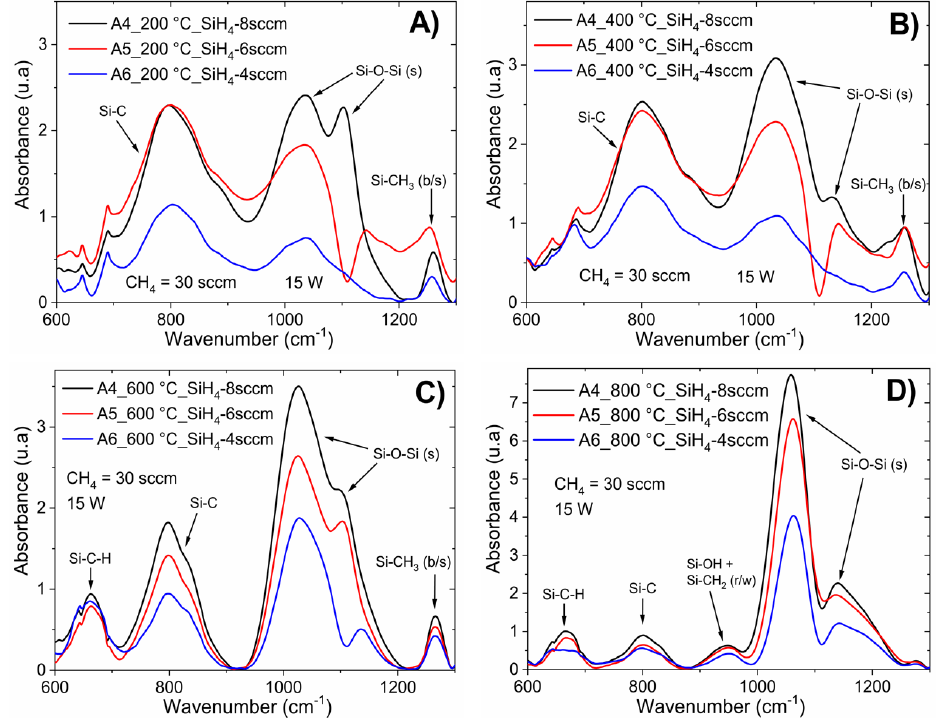
Figure 3. IR spectra for the a-Si 1 − x C x :H films deposited after fast annealing process with di ff erent R 0 ratios (from 37.5–75) and constant RF power at 15 W; upon fast annealing process at 200 ( A ), 400 ( B ), 600 ( C ), and 800 ◦ C ( D